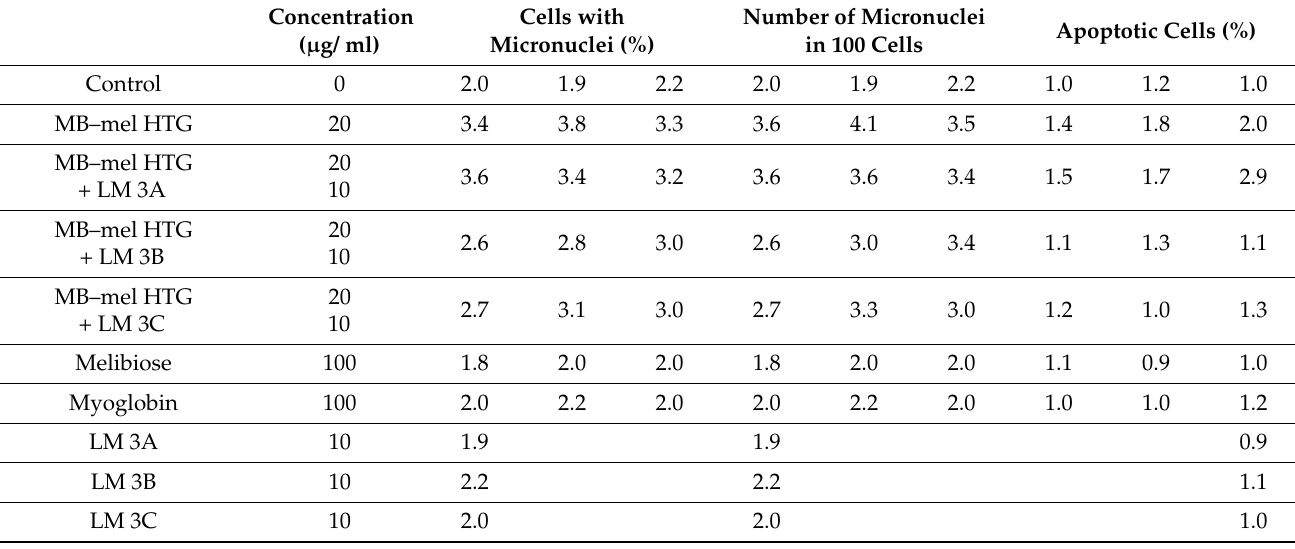
Table 9. The effect of LMW–MAGE on genotoxic activity of HTG glycation products in A549 cells.